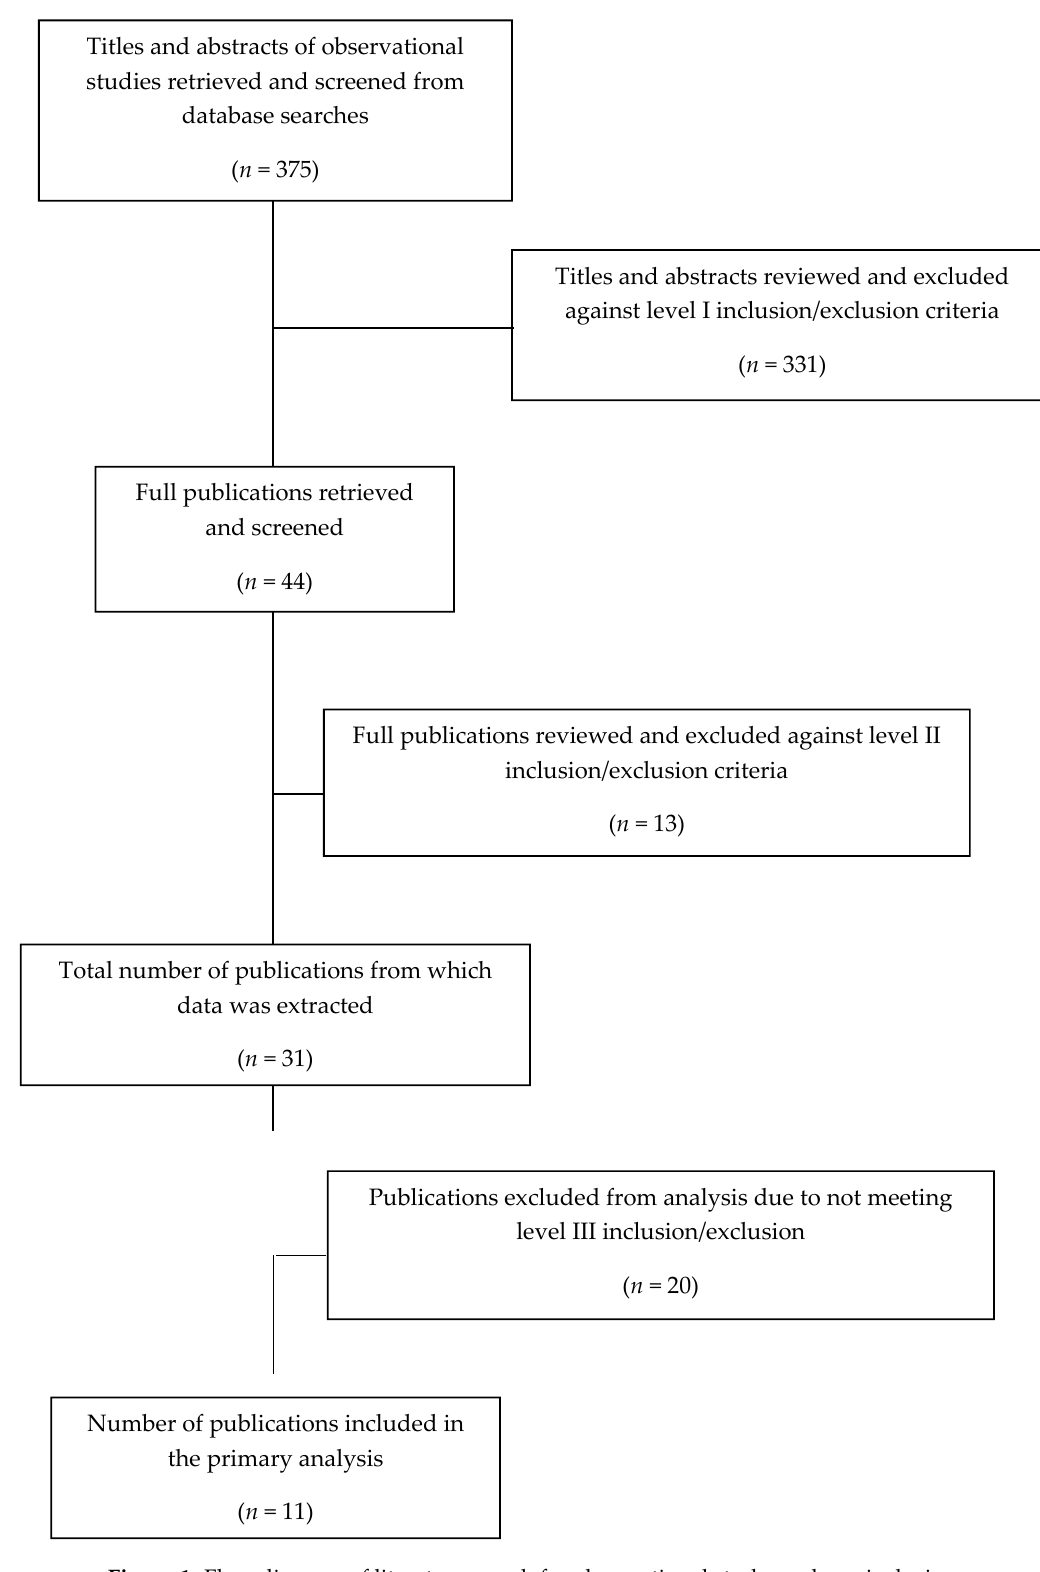
Figure 1. Flow diagram of literature search for observational study analyses